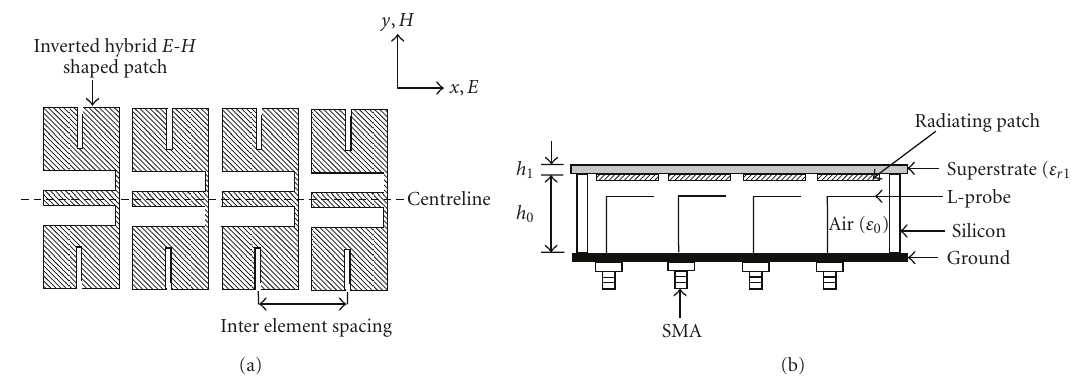
Figure 2: (a) Top view and (b) side view of the 4 × 1 LIEH patch elements.